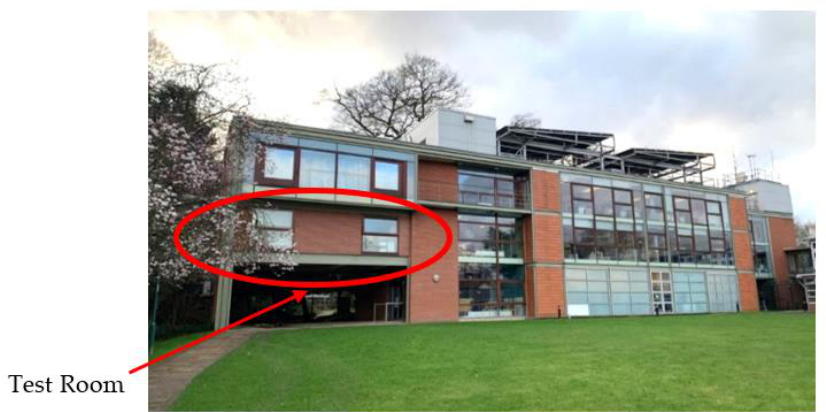
Figure 4. An image of the Sustainable Research Building, with the highlighted office space (Room B12) used as experimental test room for this present study.